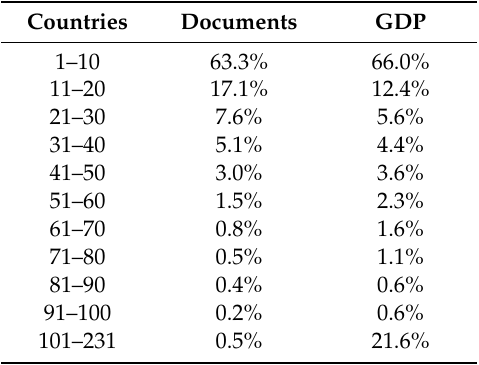
Table 2. Comparison of scientific output and GDP 1